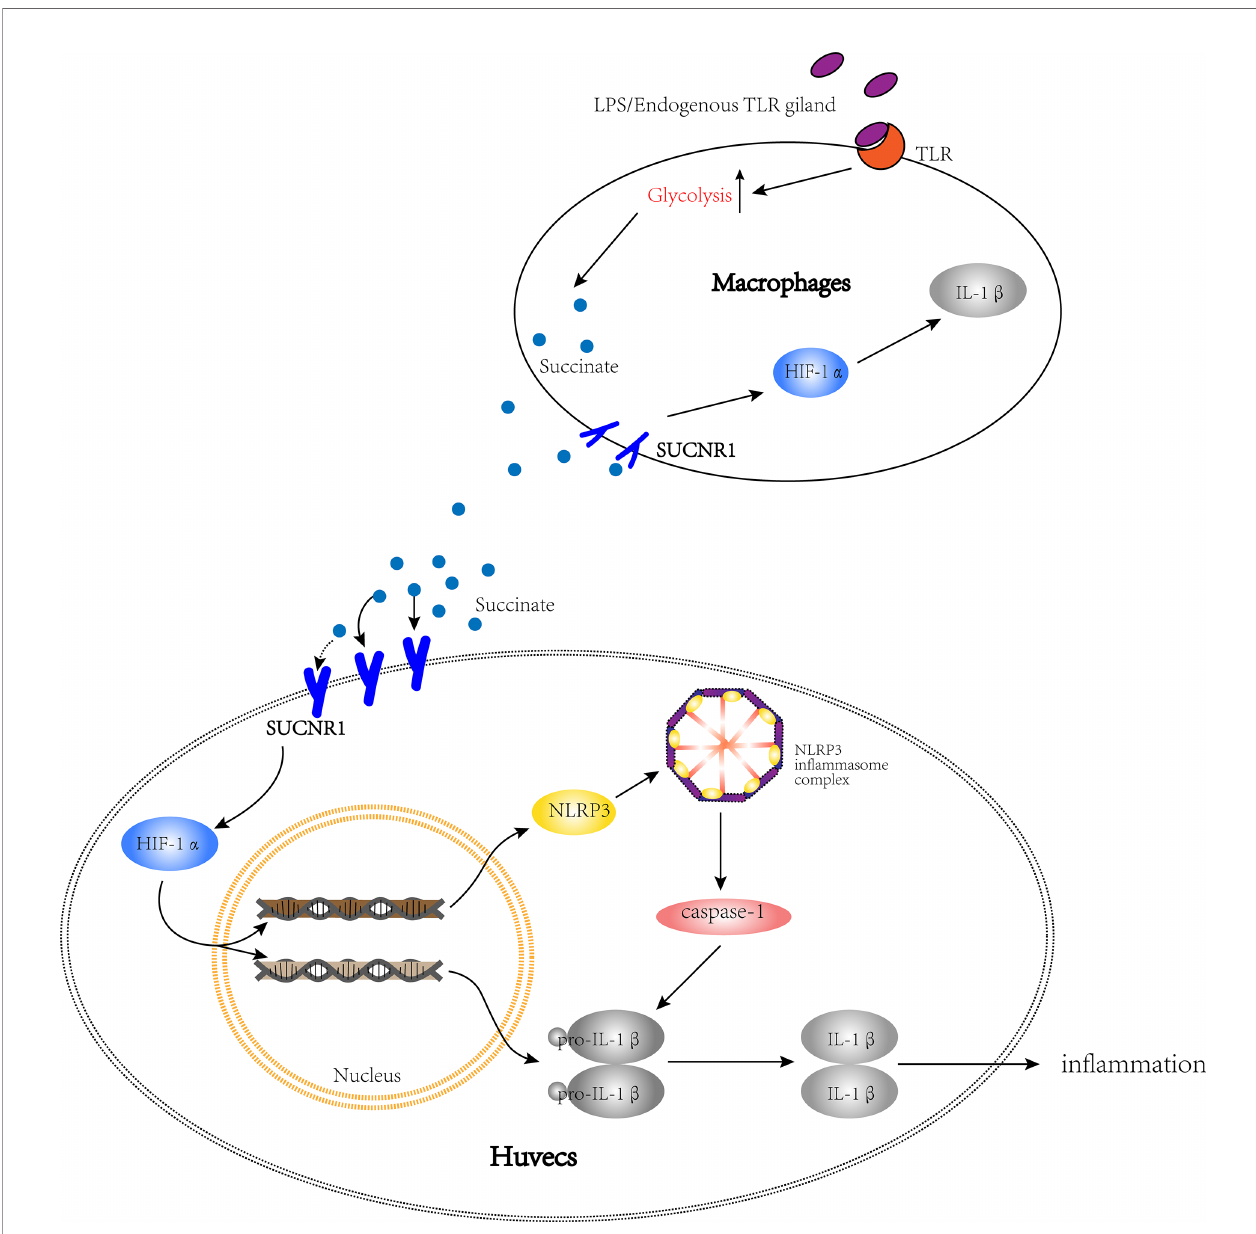
FIGURE 10 | The path diagram of succinate/IL-1 b signal axis between HUVECs and macrophages. The bigger cell is HUVEC, while the smaller one is macrophage. This fi gure shows that after being activated, macrophages release succinate and stimulate the succinate/IL-1 b signal axis in HUVECs to promote an in fl ammatory